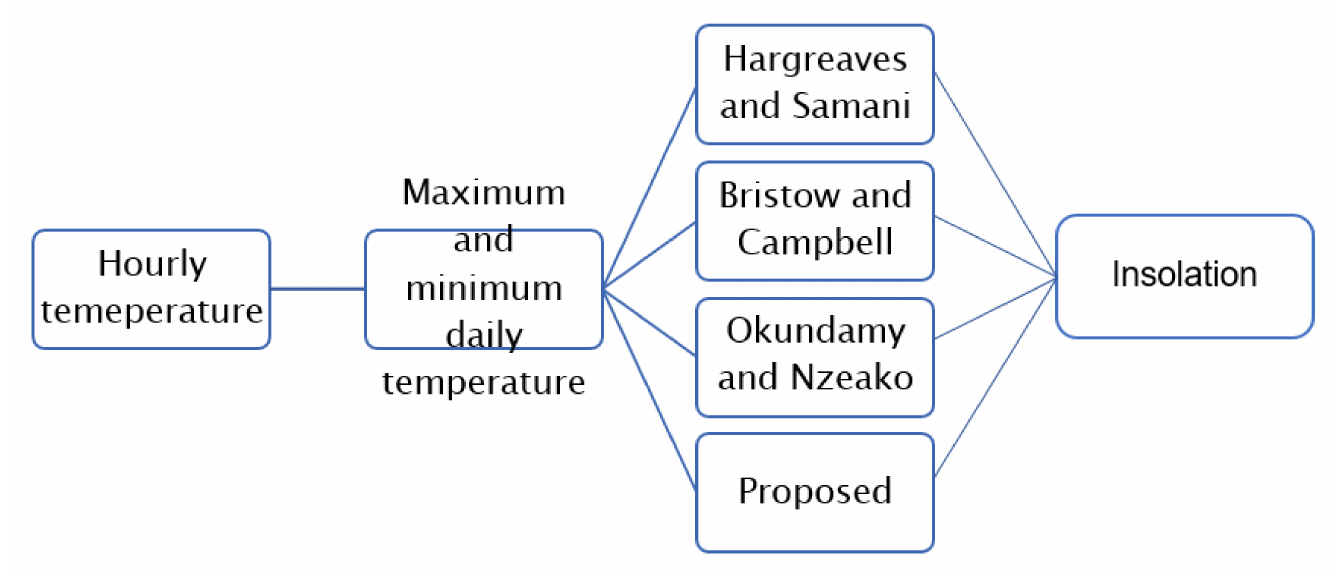
Figure 2. Scheme for empirical model